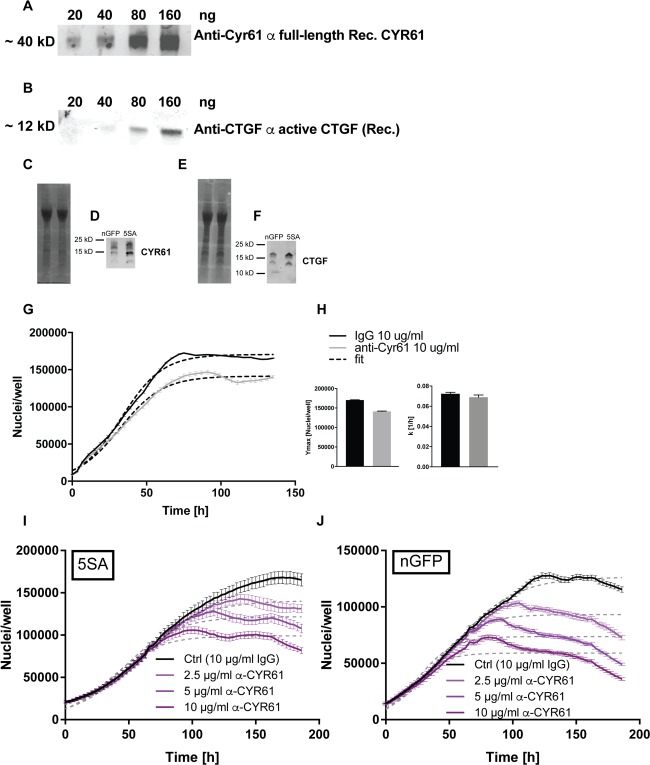
Validation of anti-CYR61 and anti-CTGF antibodies.(A) The primary anti-Cyr61 antibody used in our assays recognizes titrated amounts of recombinant full length CYR61 (Peprotech). (B) The anti-CTGF antibody (Peprotech) recognizes the 12 kD peptide of recombinant active form of CTGF (Peprotech). Serum-free conditioned medium from FlipinTrex cells expressing nGFP or 5SA for 6 days was concentrated using Amicon filters. Equal amounts of total protein were loaded on a gradient tris-acetate gel and transferred to a nitrocellulose membrane for further probing using the antibodies in (A and B) (C, E). No full length CYR61 or CTGF was detectable in the concentrates, just the processed forms of CYR61 (D) and CTGF (F) which appear to be post-translationally modified to various degrees as indicated by the presence of several bands of higher molecular weight. (G, H) Pure cultures of flipinTrex-293 cells treated with 10 μg/ml of anti-CYR61 have a lower Ymax compared to those treated with polycolonal rabbit IgG as a control, but k is not significantly different. n = 5, mean ± SEM. (I, J) The effect of a second anti-CYR61 antibody raised against a different epitope of CYR61 was validated to have similar effects on population growth dynamics as the antibody we use throughout the manuscript. Pure cultures of YAP5SA and nGFP FlipinTrex cells show a titratable reduction in Ymax when treated with the 2nd antibody in comparison with 10 μg/ml of the polyclonal IgG control.